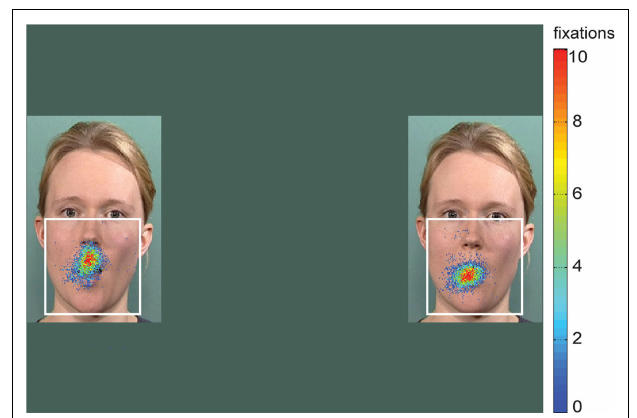
FIGURE 2 | A typical gaze map. Colours represent the number of fi xations to a given point, red colour showing the areas with most fi xations. ROIs are marked with white